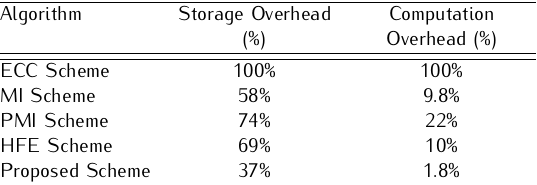
Table 1. Computational overhead and storage overhead for the pro- posed scheme.